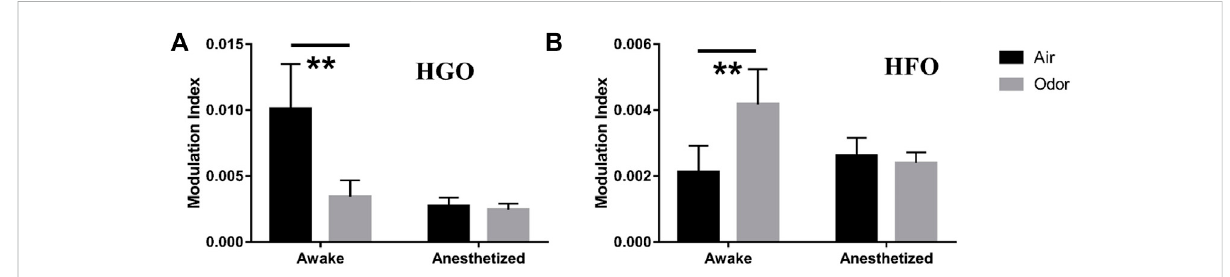
FIGURE 7 (A) Mean modulation index values of Θ -HGO coupling (pair of frequencies ranging 4 – 12 Hz for phase frequency, 60 – 100 Hz for Amplitude Frequency)inthreeawakeandthreeanesthetizedratsunderairandodorsstimulation. (B) Meanmodulationindexvaluesof Θ -HFOcoupling(pairof frequencies ranging from 4 – 12 Hz for phase frequency, 130 – 180 Hz for Amplitude Frequency) in 3 awake and 3 anesthetized rats under air and odorsstimulation.Thetrial-averageddataarepresentedasthemean±SEM, n =12,4trialsperrat.** p < 0.01,* p < 0.05,andANOVAfollowedby Fisher ’ s least signi fi cant difference